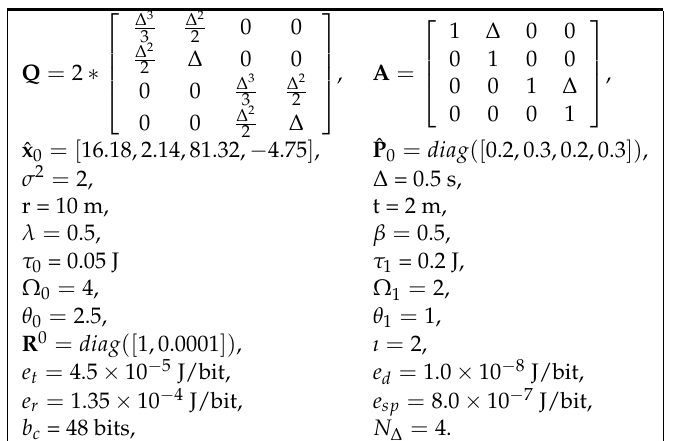
Table 2. The settings of system parameters in our simulation environment.